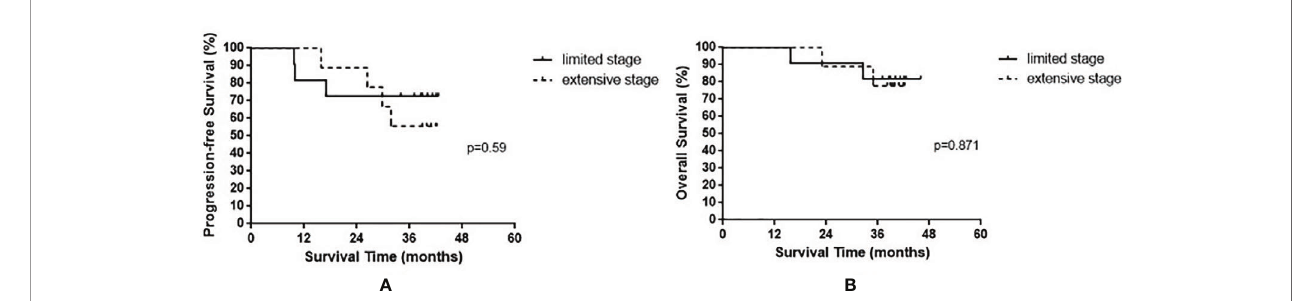
FIGURE 2 | Progression-free survival (A) and overall survival (B) in small cell lung cancer patients based on limited stage and